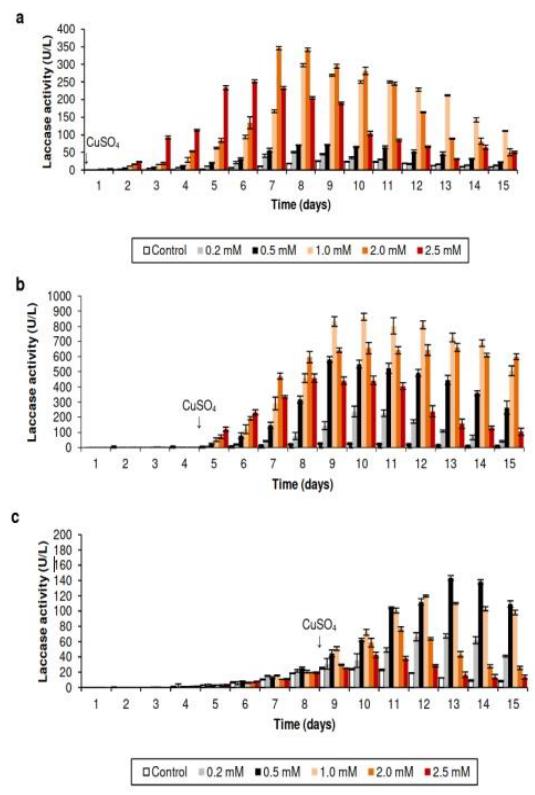
Figure 3. Effect of copper on the laccase production by T. terrestris Co3Bag1. Medium HCHN, supplemented with different concentrations of CuSO 4 (0.2 to 2.5 mM), was added during three phases of incubation: ( a ) start of culture (0th day); ( b ) middle logarithmic phase (4th day); and ( c ) stationary phase (8th day).